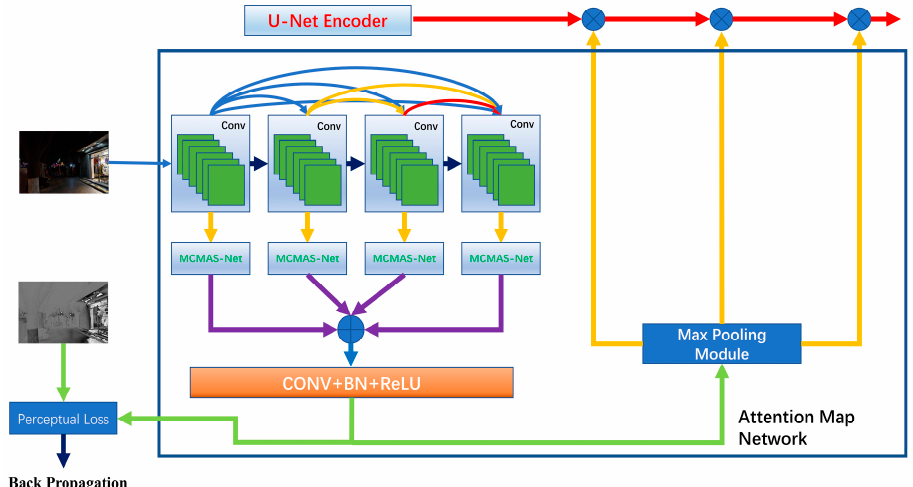
Figure 3. Network Structure of the Attention Map Network.